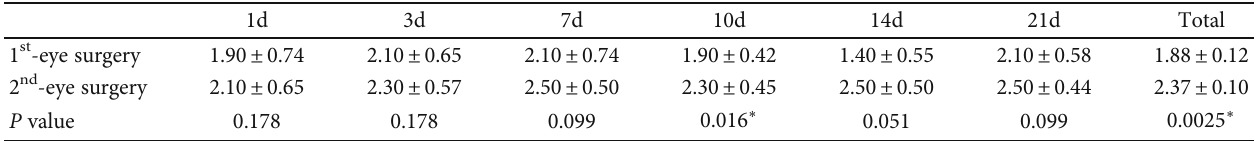
Figure 3: Concentrations of TNF- α and IL-1 β in AH of experimental rabbits. Group A: monocular phacoemulsi fi cation; Group B: blank control. Table 1: Comparison of NRS scores during bilateral cataract